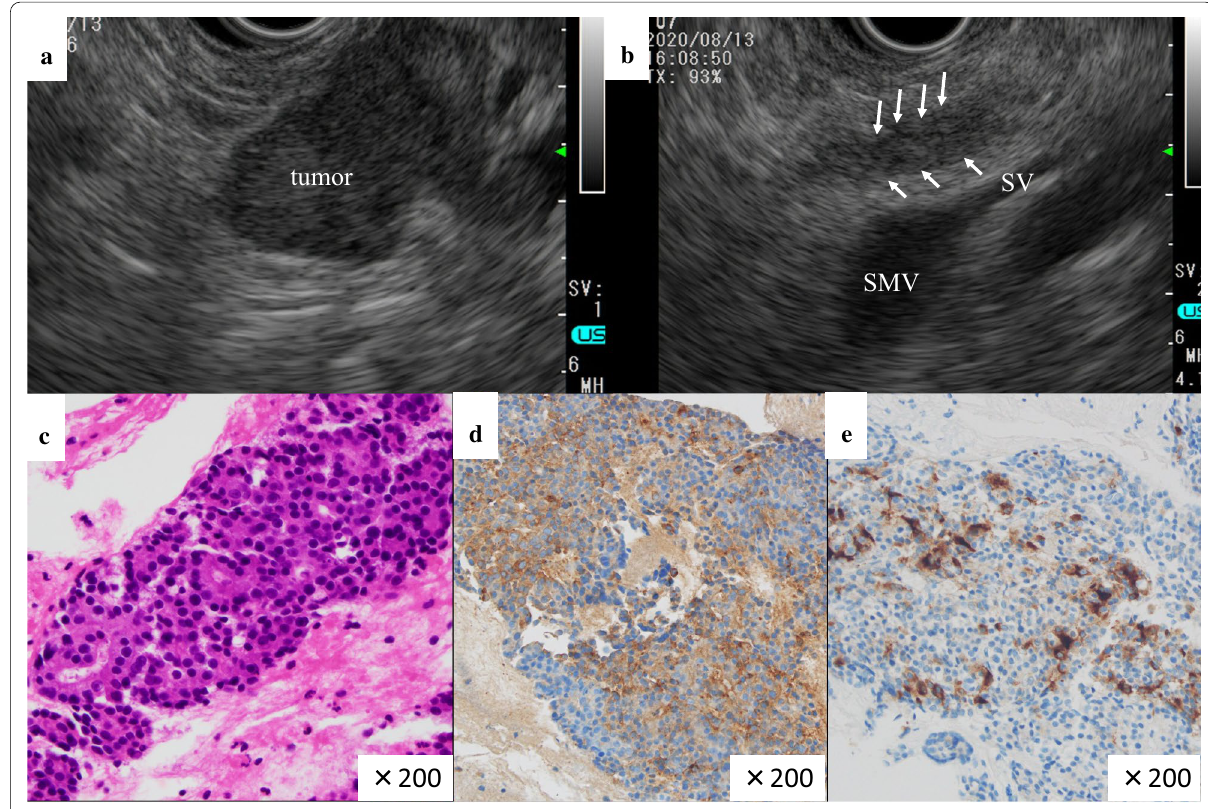
Fig. 3 The scheme illustrates the tumor progression based on the preoperative radiographic examinations. The blue dashed line indicates the MPD. The red color represents the tumor. The green line indicates the pancreatic